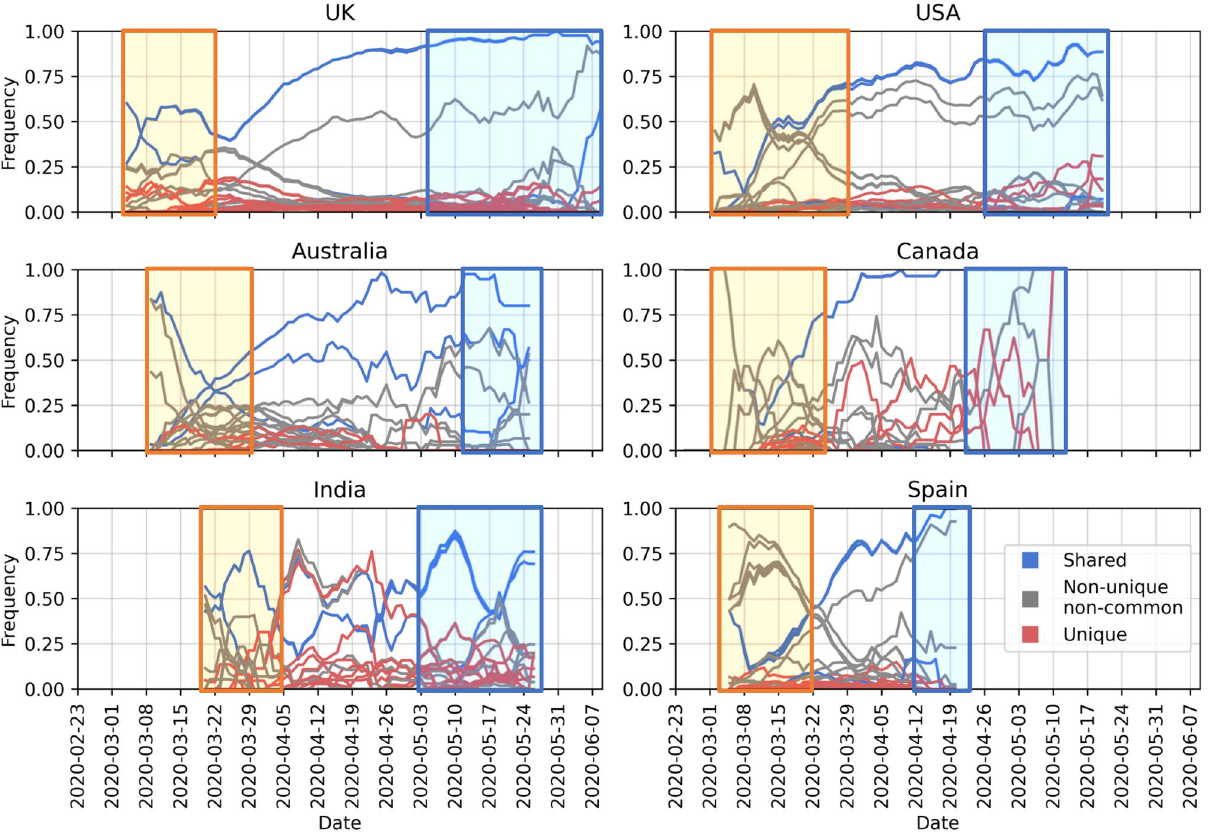
Figure 6. Change in frequency of the top 15 mutations in the most-sampled countries in our dataset: y-axes show mutation frequency (number of mutations per sample) averaged over a period of 7 days where periods with fewer than one sample per day were removed and x-axes show the collection date. Line colors were kept consistent with Fig. 5: blue lines are mutations shared across all these countries in the top 15, while the red lines are unique to that one country in the top 15 and the gray lines are non-unique and non-common variants where the mutation is observed in more than one country. Areas highlighted in yellow and blue as, mentioned in text, to indicate pre-lockdown and